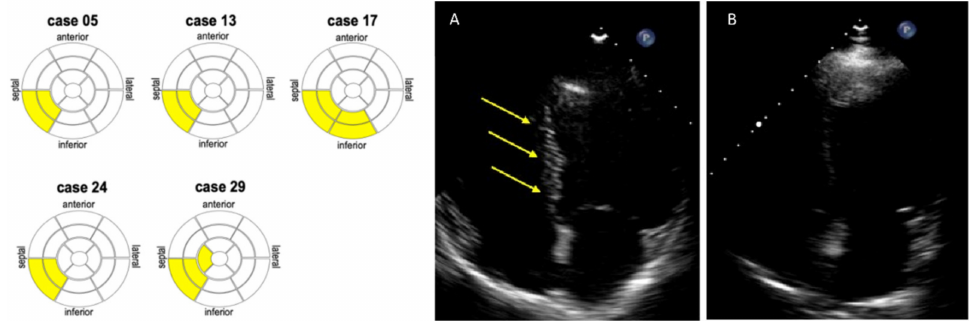
Figure 1. On the left: myocardial fibrosis in five patients with SLE, as described by a 17-segment “bull’s eye” scheme. Yellow segments show the localization of the echocardiographic scar (eSCAR) sign as detected by pulse cancellation imaging. On the right: the presence of myocardial fibrosis in the interventricular septum (i.e., eSCAR-positive patient) is shown in panel ( A ). The absence of myocardial fibrosis (eSCAR-negative patient) is shown in panel ( B